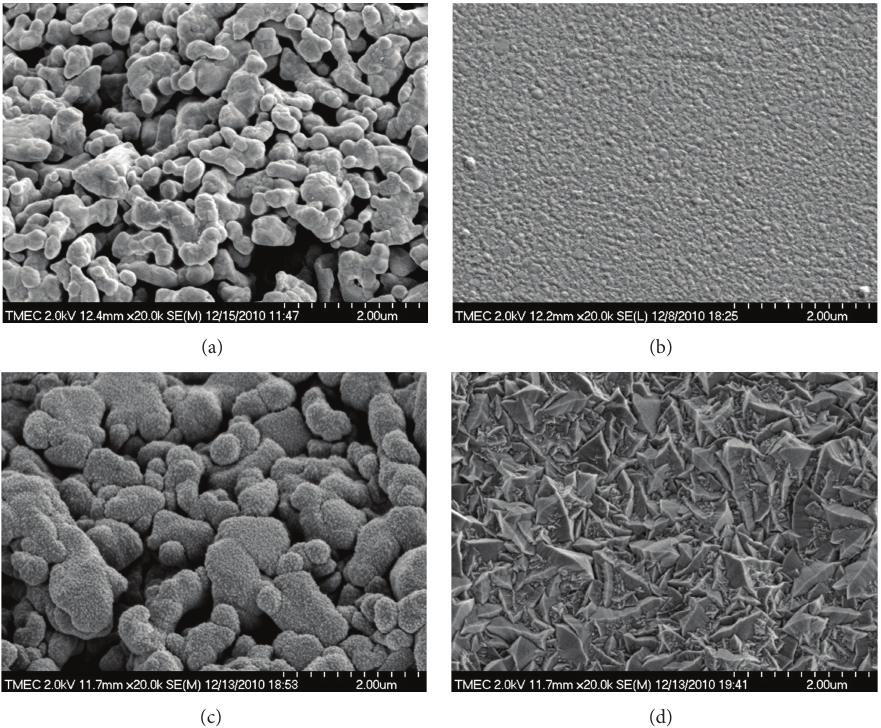
Figure 1: Surface morphology of (a) screen printed Ag on PI, (b) sputtered Ag on PI, (c) sputtered ZnO/screen printed Ag on PI, and (d) MOCVD ZnO/screen printed Ag on